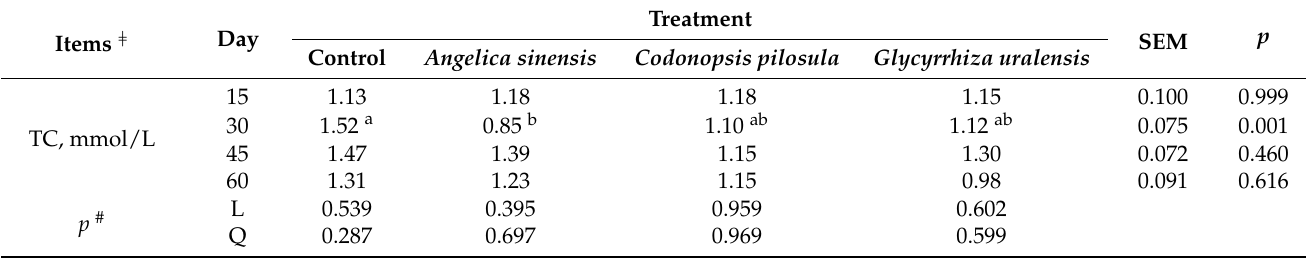
Table 1. Serum biochemical parameters of early weaned yak calves consuming different herbal